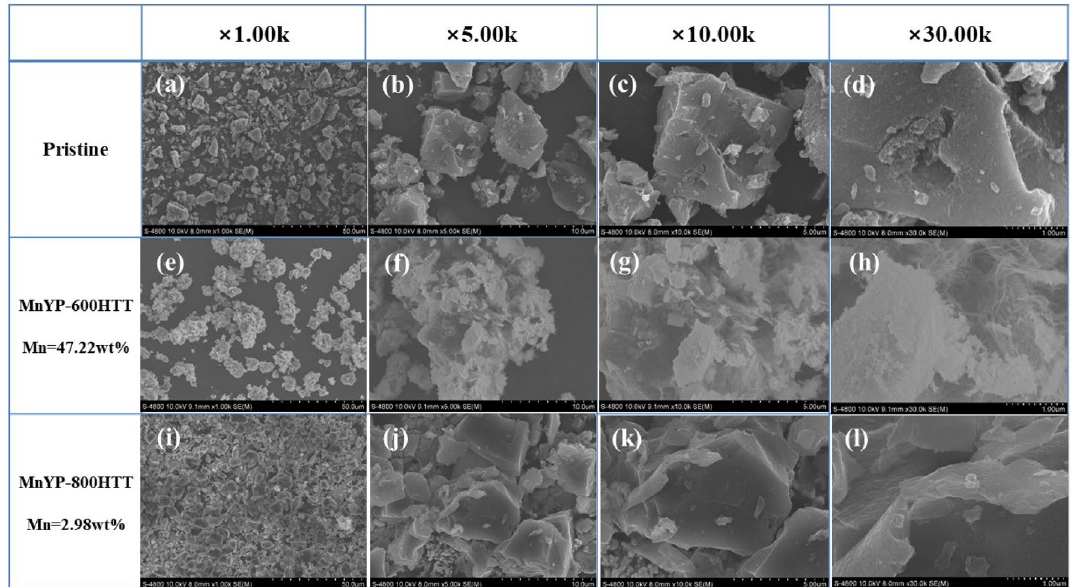
Figure 4. SEM images of Pristine, Mn-doped MnYP-600HTT and